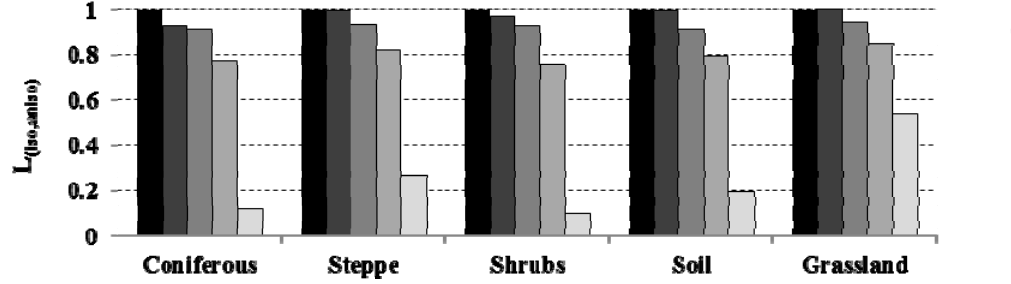
Figure 6. Correlation between anisotropic and isotropic radiance values for 5 solar zenith angle classes and 5 different